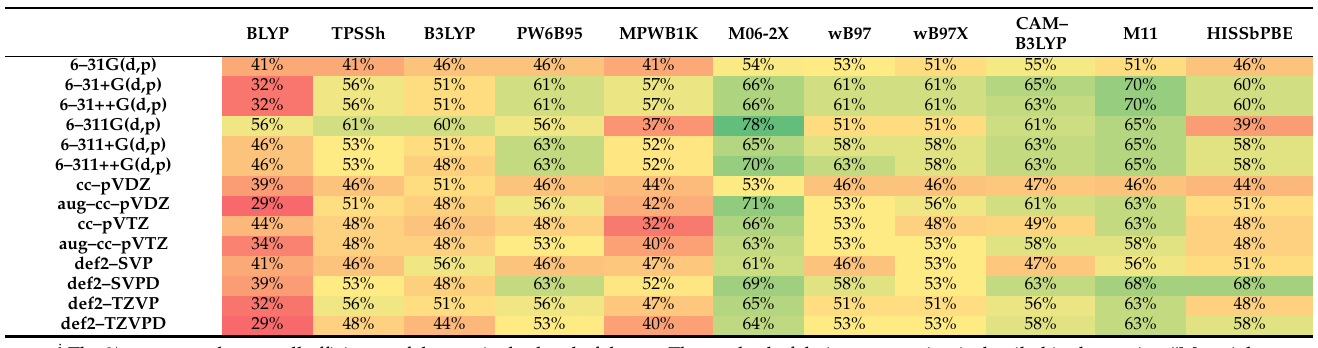
Table 1. The final score of each combination studied i .